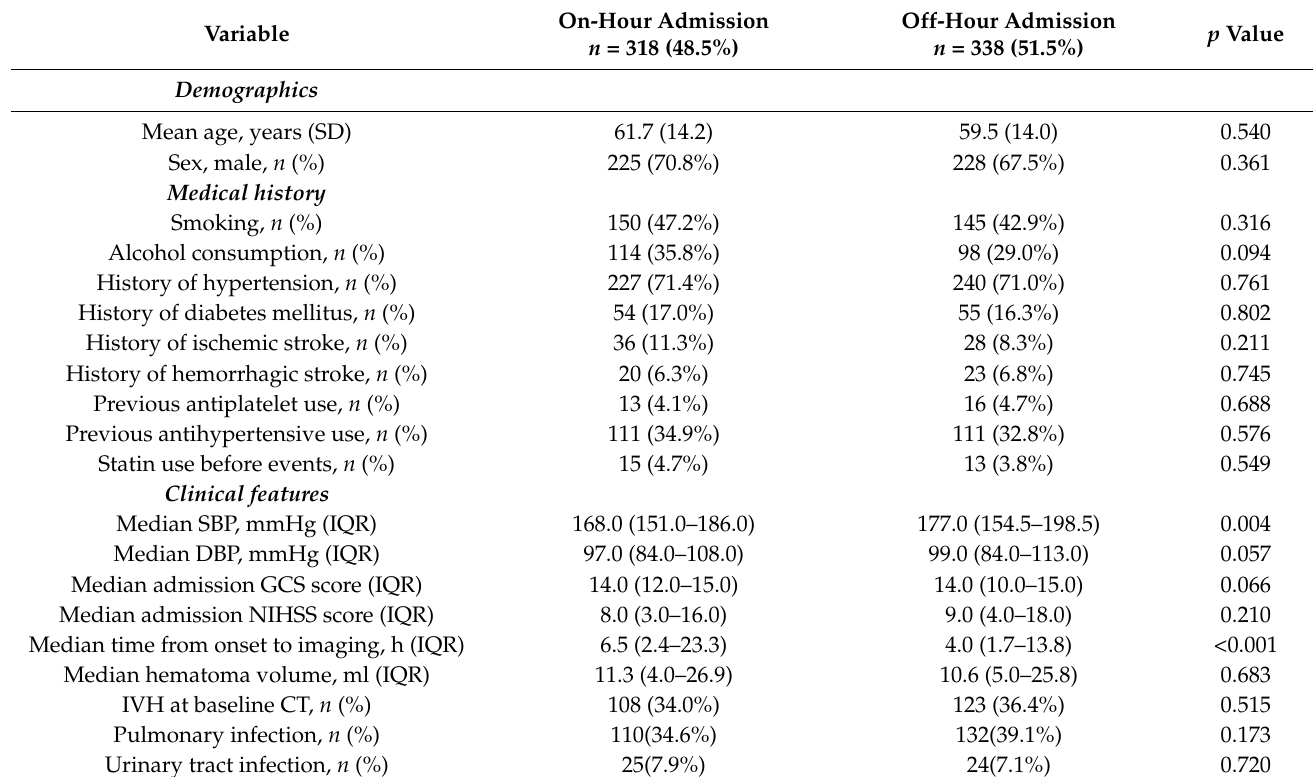
Table 1. Demographic data and baseline characteristics of ICH patients at time of admission ( n =